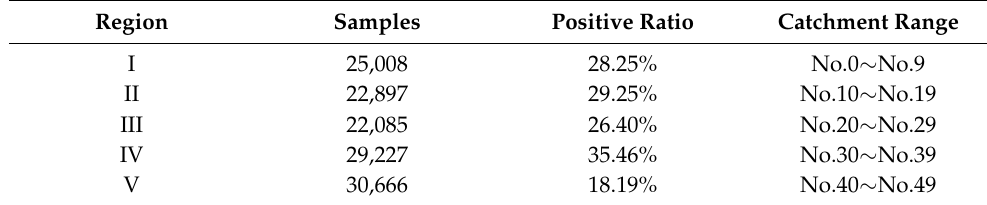
Table 2. Description of Regional Data Sets.